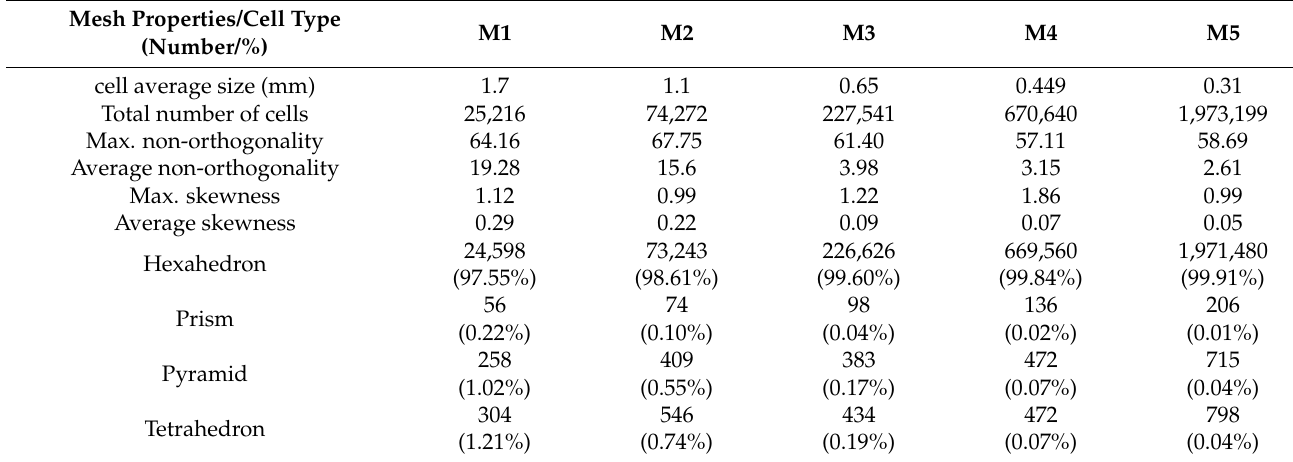
Table 3. Toe cap meshes